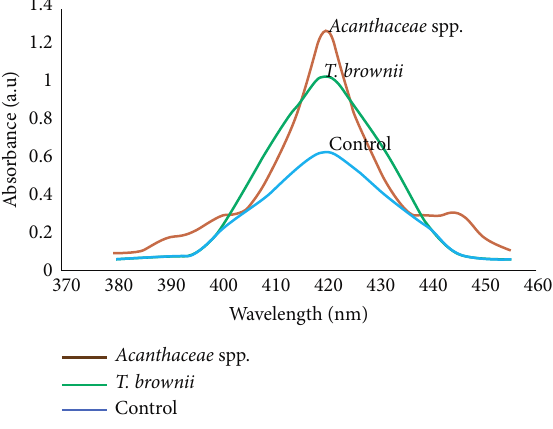
Figure 4: Bioslurry sulfate levels after retention day 28. Table 8: Variation of total phosphorus, total phosphoric acid, and free phosphates in bioslurry over the retention period. Samples